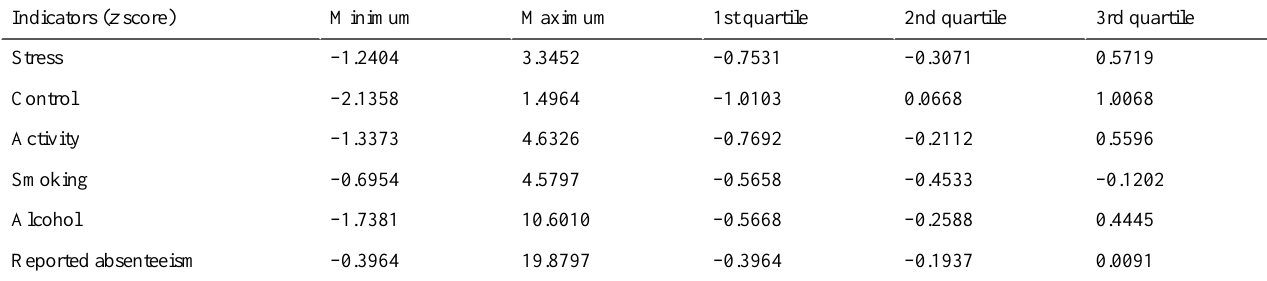
Table 4. Descriptive data of classification variables (N = 683